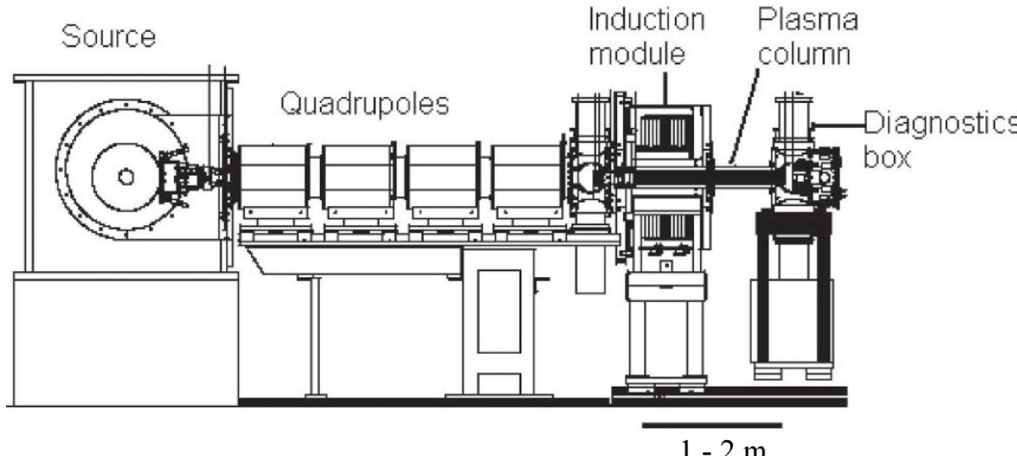
FIG. 1. Schematic of the NDCX-1A experimental setup.